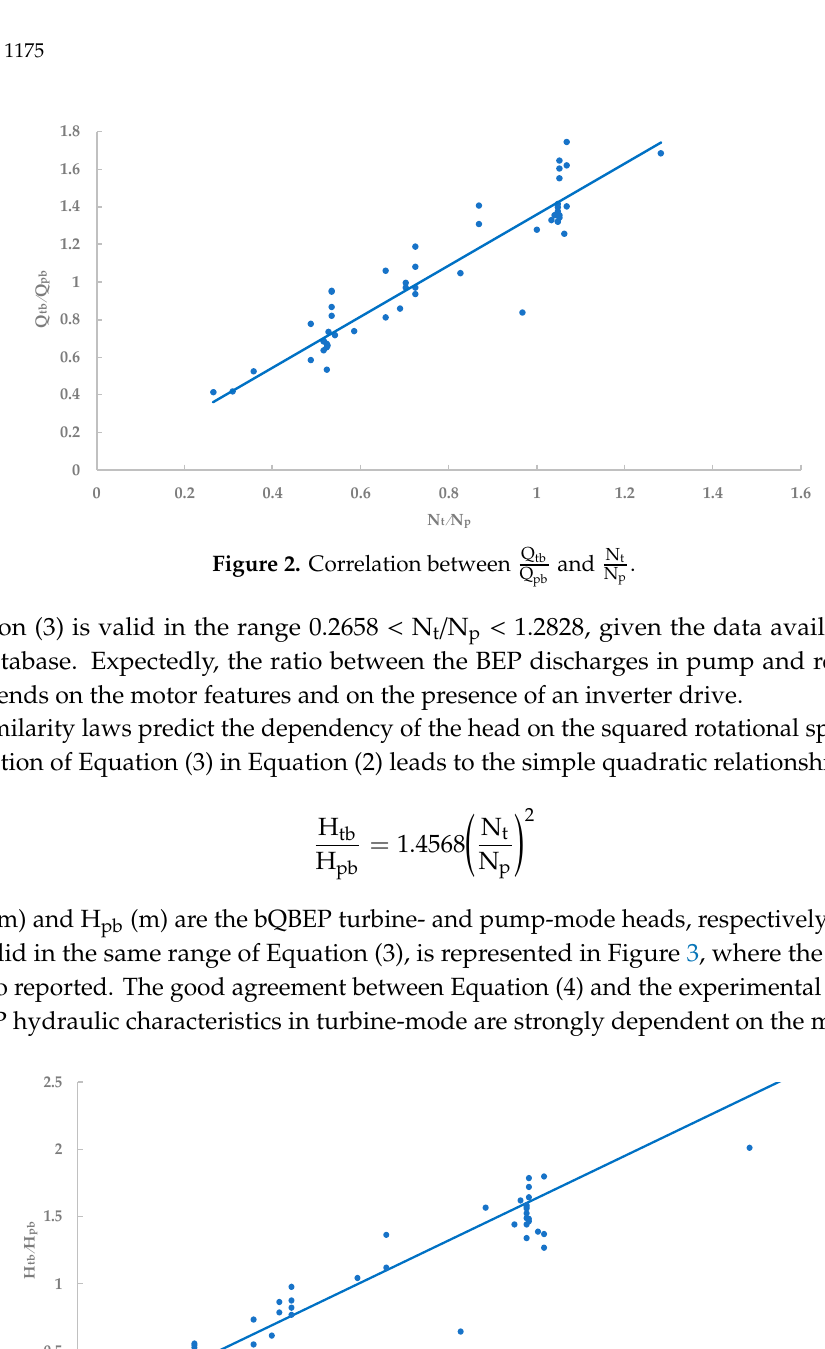
H tb H pb (cid:3416) and the square of and the square of N t H tb H pb H pb (cid:3416) and the square of